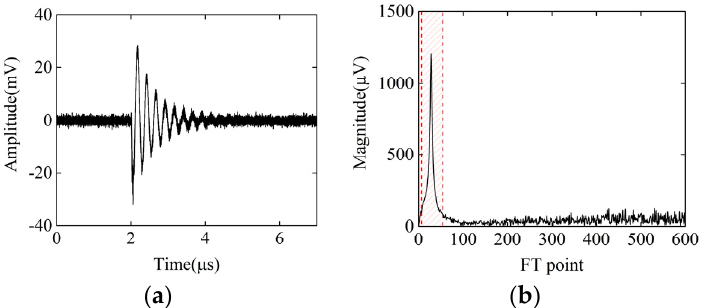
Figure 3. Time domain and frequency domain waveforms of the PD signal in a practical test. ( a ) Time domain waveform; ( b ) Frequency domain waveform.